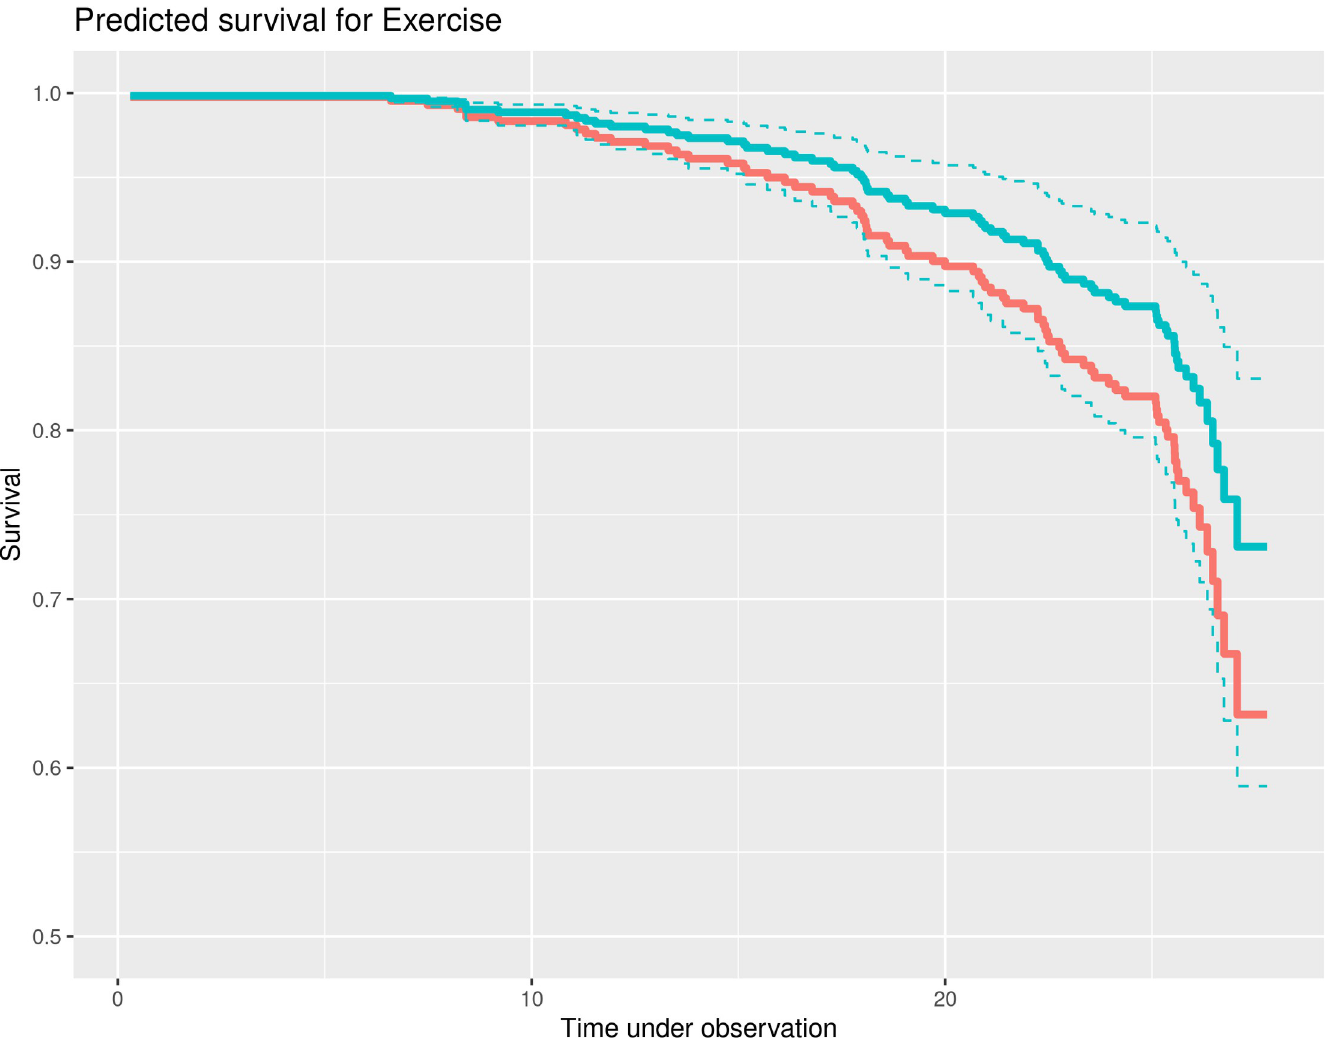
Fig 4. Predicting survival for exercise in healthy women. Moderate exercise seems to be beneficial, showing an increase in survival of 10%